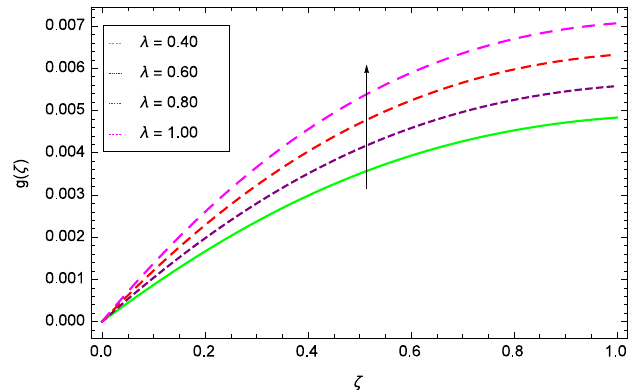
Figure 19. Parameter effect on velocity g ( ζ ) profile.